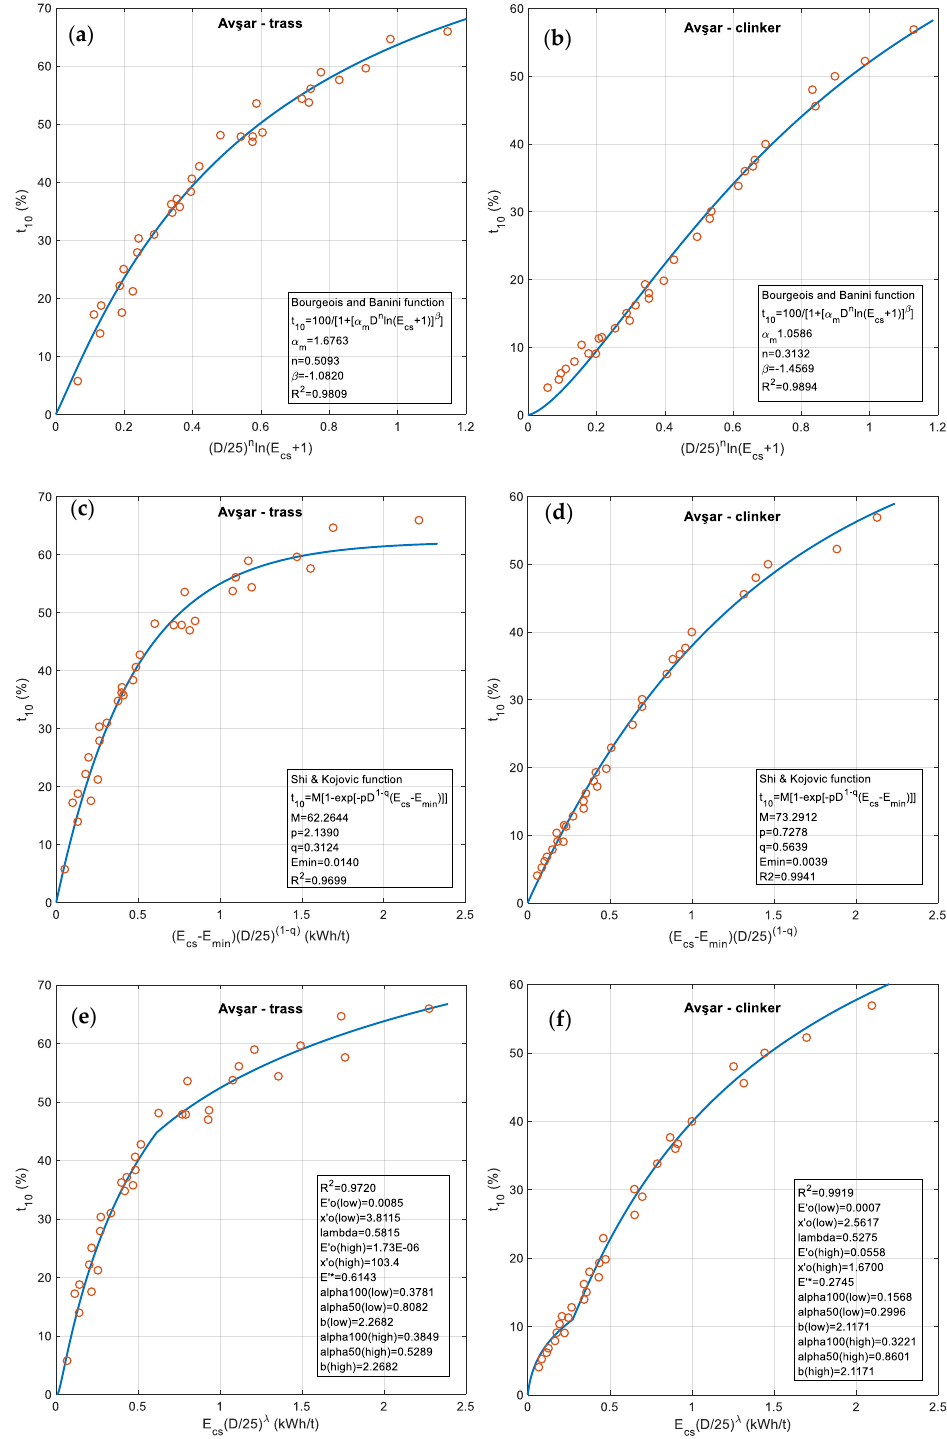
Figure A9. Breakage index plots for ( a , c , e ) Avsar’s trass and ( b , d , f ) Avsar’s clinker. ( a , b ): Banini’s BIE, ( c , d ): JK new BIE and ( e , f ) double fan BIE. For tr ass, the higher determination is Banini’s ( 𝑅 2 = 0.9809); for clinker, it is JK (with 𝐸 𝑚𝑖𝑛 > 0 , 𝑅 2 = 0.9941).